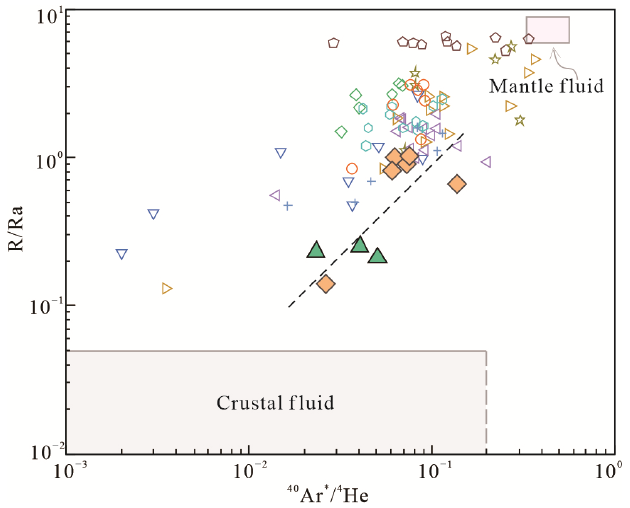
Figure 6. R/Ra vs. 40 Ar*/ 4 He plot of the ore-forming fluids from the Xingluokeng W-Mo polymetallic deposit. The values of mantle fluids and crustal fluids are quoted from [18]. The linear correlation was obtained by least squares regression: 3 He/ 4 He (Ra) = 6.0 × 40 Ar*/ 4 He + 0.22, r 2 = 0.69. Symbols are the same as for Figure 5.